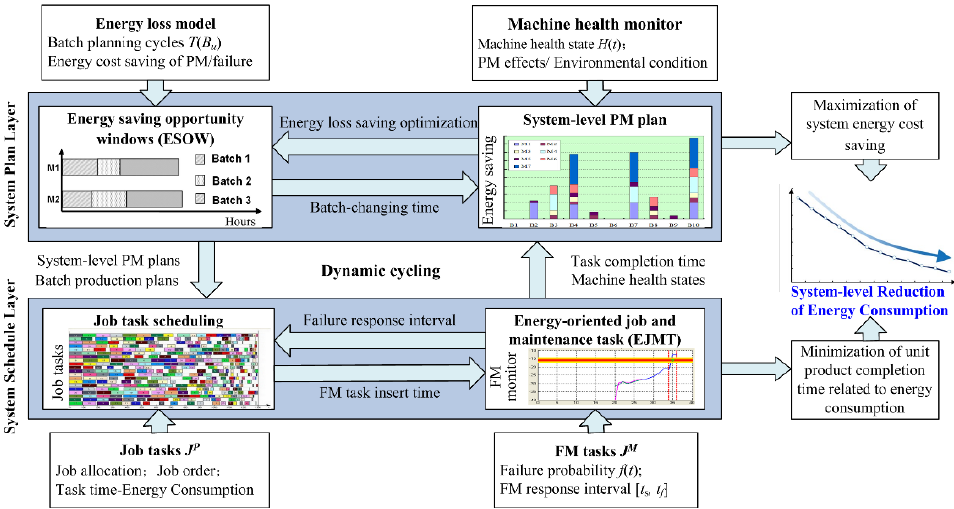
Figure 7. Optimization modeling framework of the system-level energy consumption.